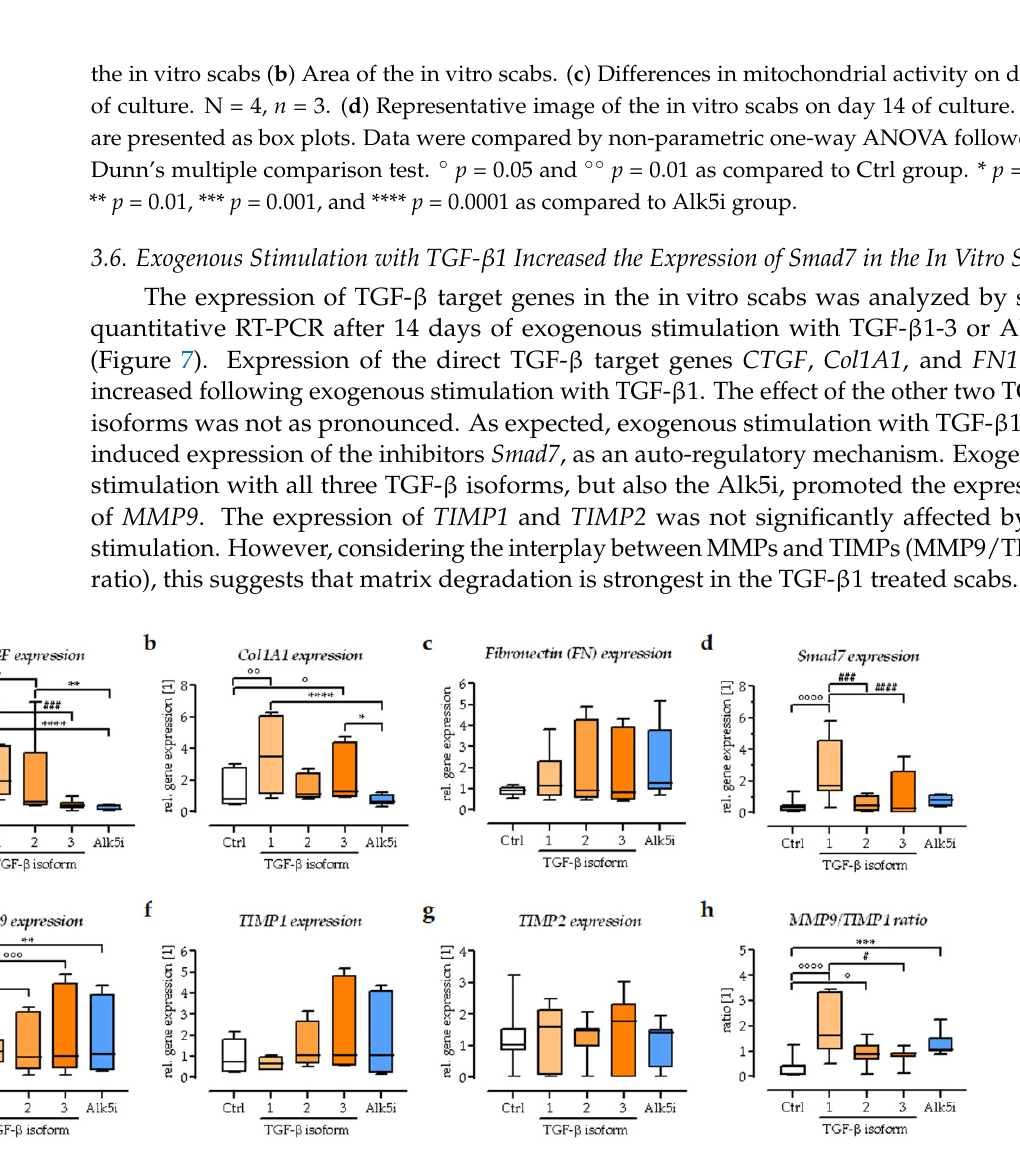
the in vitro scabs ( b ) Area of the in vitro scabs. ( c ) Differences in mitochondrial activity on day 14 of culture. N = 4, n = 3. ( d ) Representative image of the in vitro scabs on day 14 of culture. Data are presented as box plots. Data were compared by non-parametric one-way ANOVA followed by Dunn’s multiple comparison test. ◦ p = 0.05 and ◦◦ p = 0.01 as compared to Ctrl group. * p = 0.05, ** p = 0.01, *** p = 0.001, and **** p = 0.0001 as compared to Alk5i group.